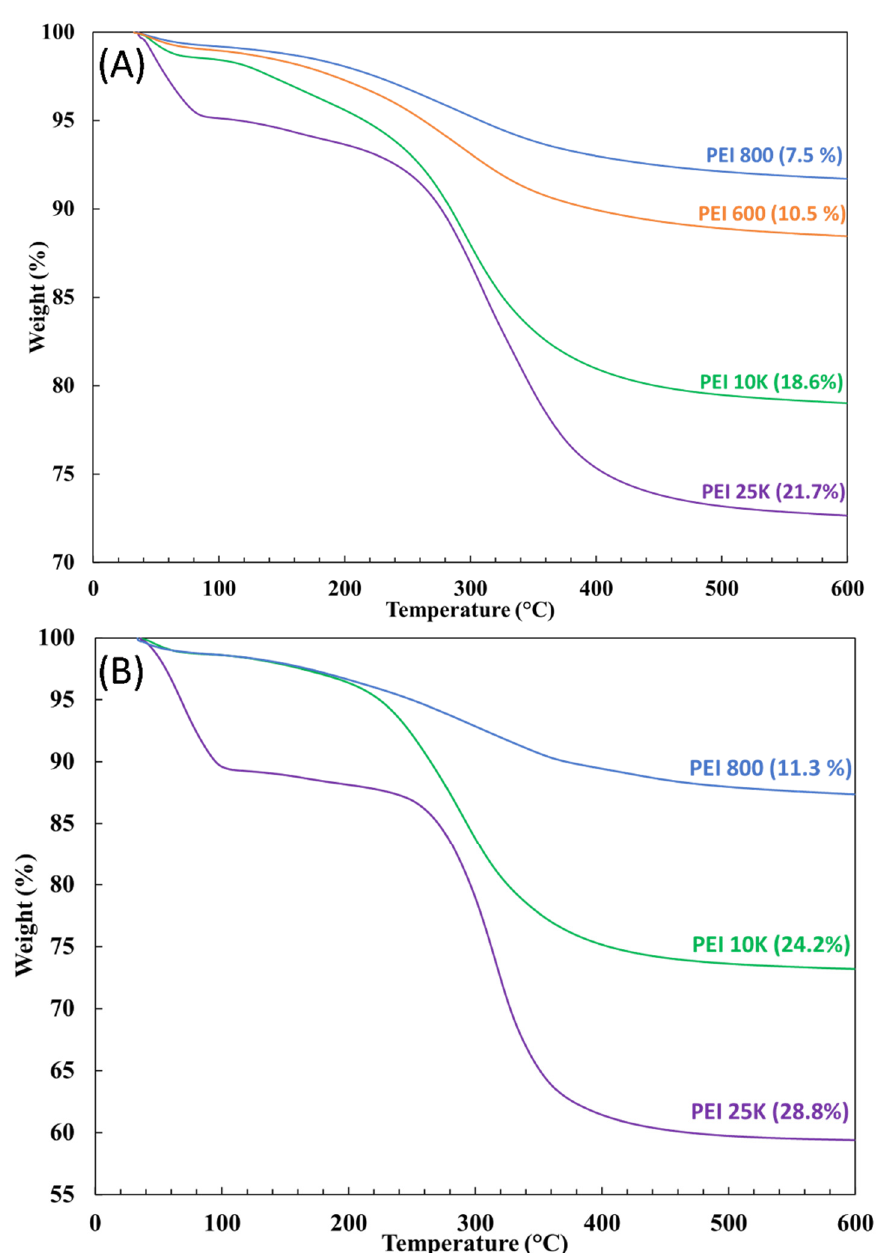
Figure 9. TGA thermograms for the samples ( A ) PEIX/3/0.5 and ( B ) PEIX/1/2.0 after extraction for different molecular weights: PEI 600 (orange line), PEI 800 (blue line), PEI 10K (green line) and PEI 25K (purple line).